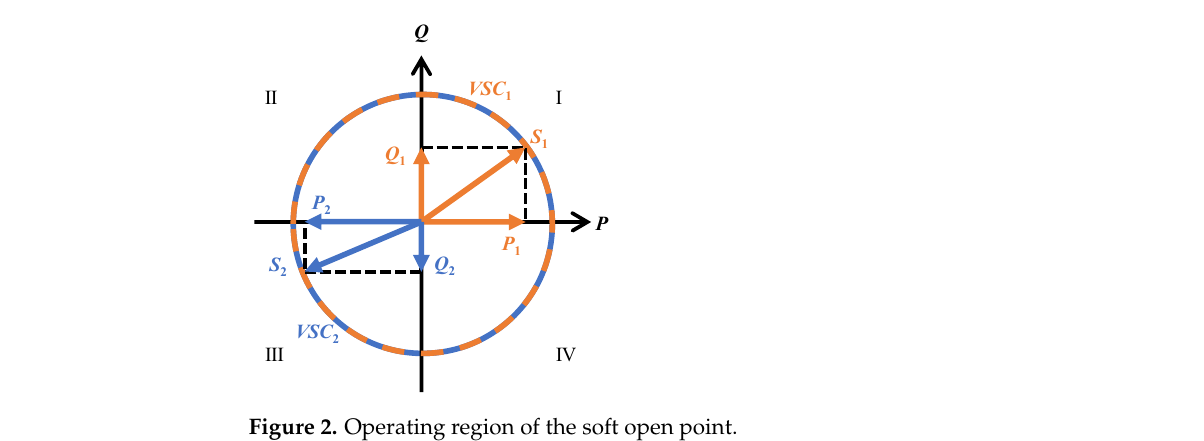
Figure 2. Operating region of the soft open point.